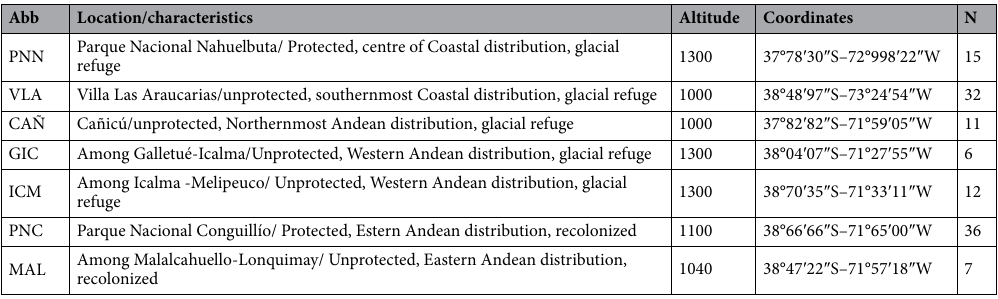
Table 6. Abbreviations (Abb) and locations of the collection sites, altitude (meters above sea level), geographic coordinates and total number of individuals